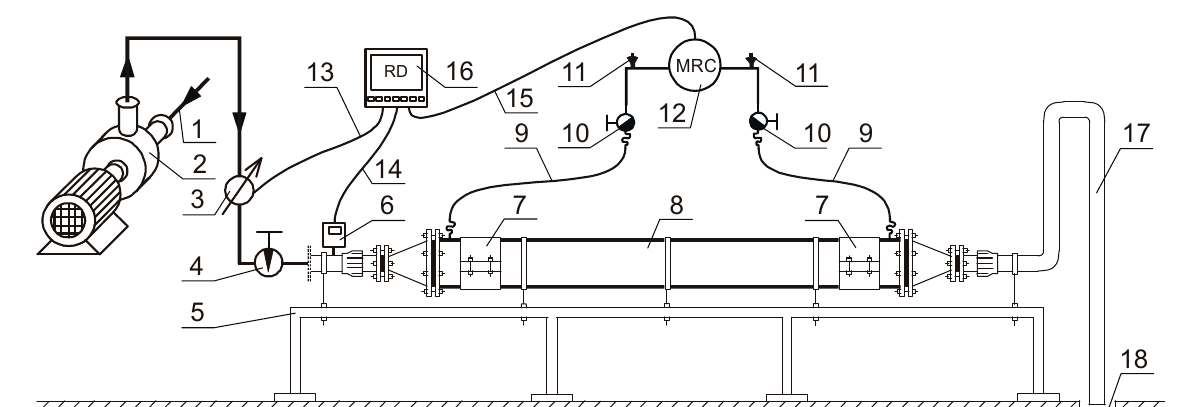
Figure 2. Scheme of a test rig for investigations of major head losses in pipes: 1—water supplying pipe; 2—pump; 3— electromagnetic water flow meter; 4—needle valve controlling water flow rate; 5—frame carrying pipes; 6—thermometer; 7—clamping sleeves; 8—cast-iron pipe; 9—impulse hoses; 10—cut-off ball valves; 11—breathers; 12—piezoelectric pressure difference meter; 13, 14, 15—control cable; 16—data logger; 17—draining pipe; 18—outlet to sewerage.